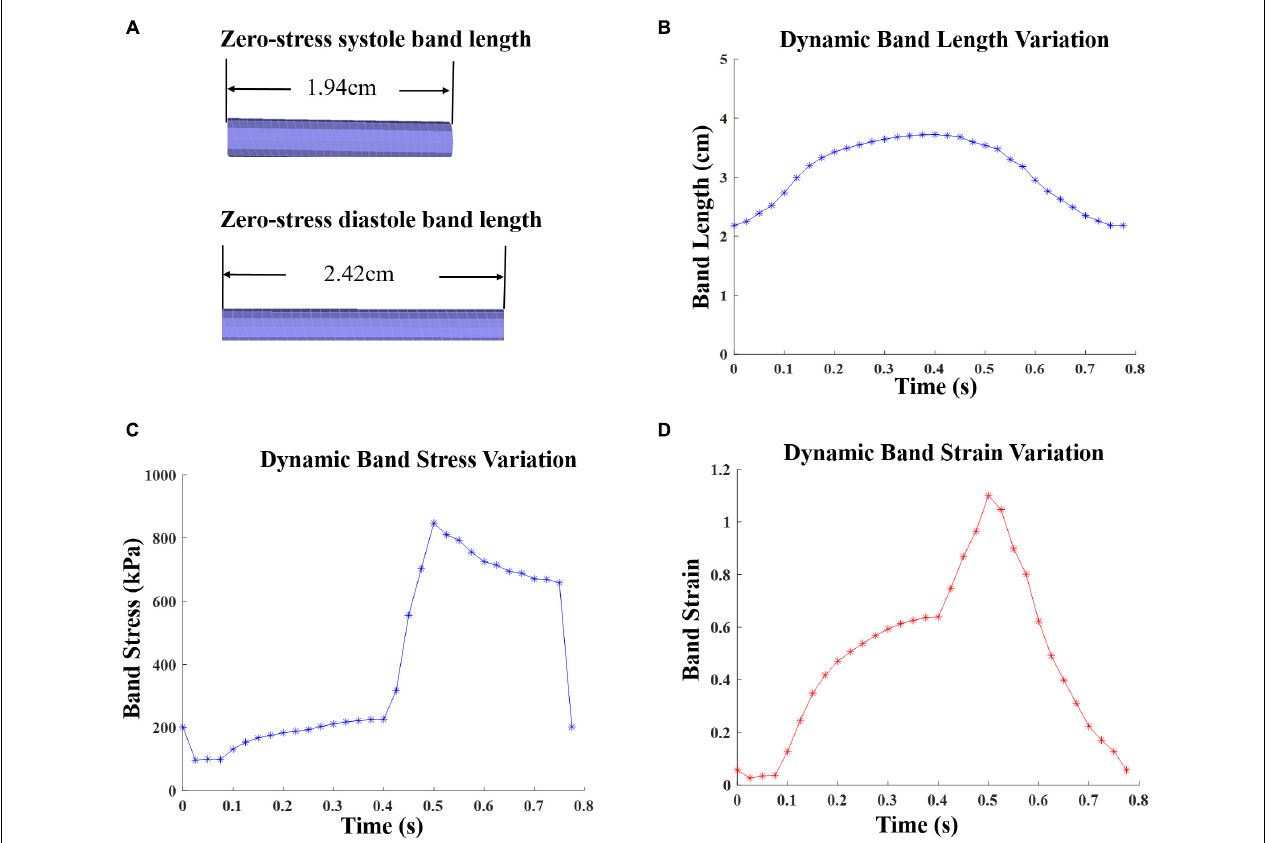
FIGURE 3 | Zero-stress band length and dynamic band stress/strain variations for patient 5 surgery plan D model with 20% active contraction ratio in the entire cardiac cycle. (A) Zero-load band length at systole and diastole. (B) Dynamic band length variation. (C) Dynamic band stress variation. (D) Dynamic band strain